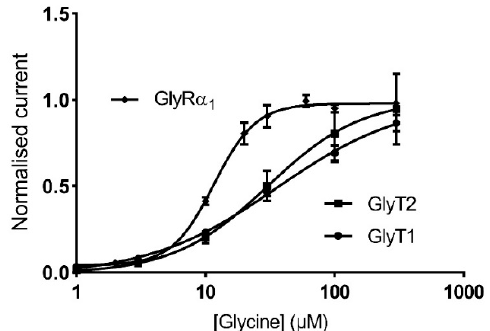
Figure 9. GlyTs create an apparent change in GlyR α 1 Hill co-efficient. Glycine dose response curves for GlyR α 1 , GlyT1 and GlyT2 showing the region in which GlyTs are most effective, i.e., their EC 50 , is asymmetrical across the GlyR α 1 curve. Currents are normalised to I max and fit to the Hill equation. Symbols are mean ± SEM ( n ≥ 5). 3.8. Novel, Bioactive Lipid Modulators of GlyR α 1 and GlyT2